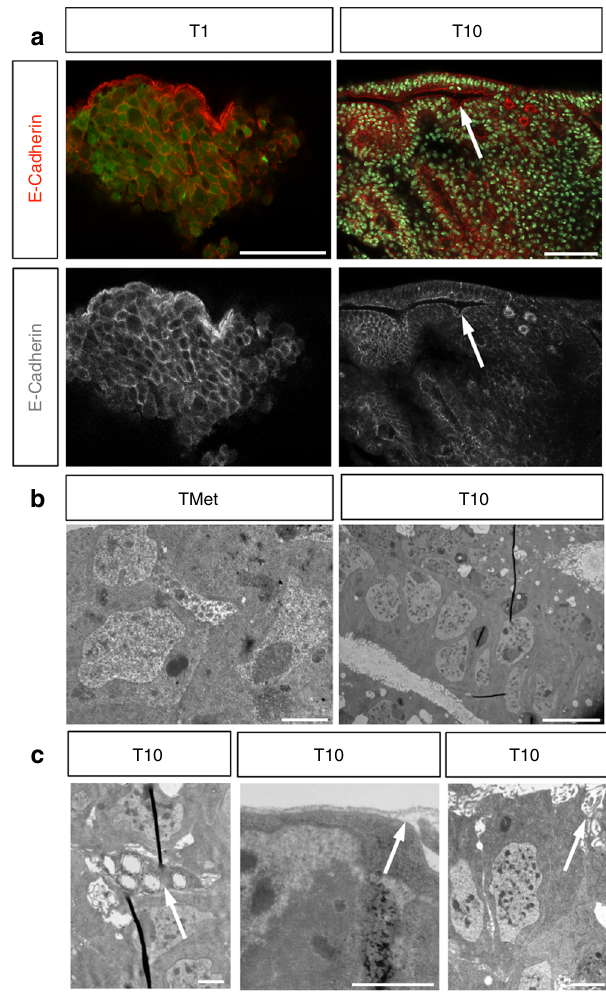
Fig. 7 Metastases re-epithelialize over time. a E-Cadherin localizes throughout the cell membranes at T1 stage (red, left), whereas in T10 it can be found tightly localized to the apical domain of cells, with lumen clearly visible (right, arrow). b , c Images taken by electron microscope of a metastatic tumor (TMet) and a stage T10 metastases. b Cells in TMets are highly irregular and disorganized (left), whereas in T10 they are organized, with a columnar shape, and form lumen (right). c Stage T10 metastases contain trachea within the tumor (left, arrow), are surrounded by a basal lamina (middle, arrow), and make apical villi-like structures (right, arrow).